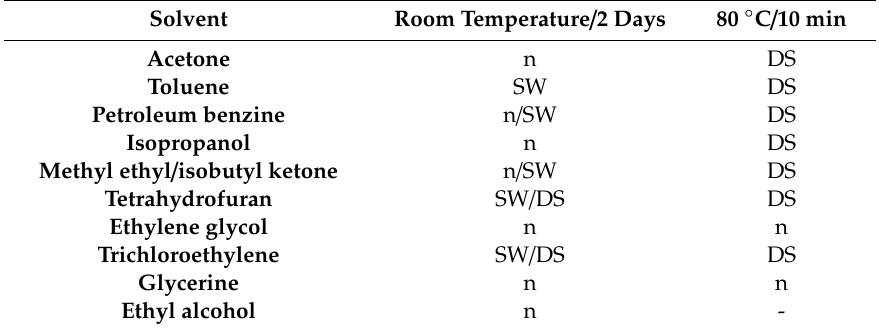
Table1. E ff ectsoforganicsolventsonthephysicalpropertiesoftheethylene-vinylacetate(EVA)polymer. Solvent